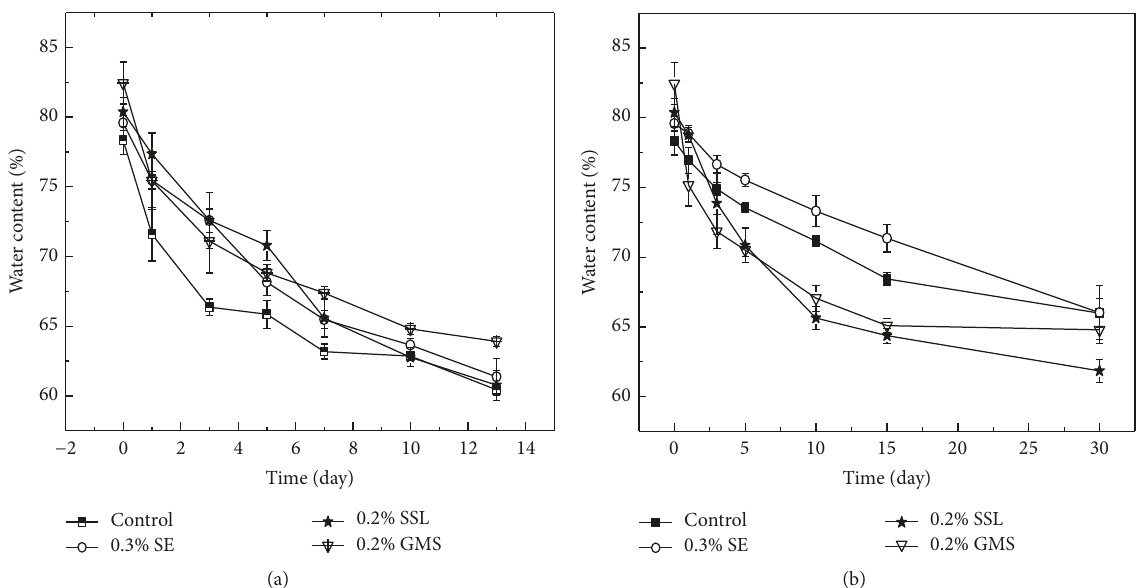
Figure 3: Water content of rice gels at different times of storage at 4 ∘ C (a) and − 20 ∘ C (b). Error bars indicate standard